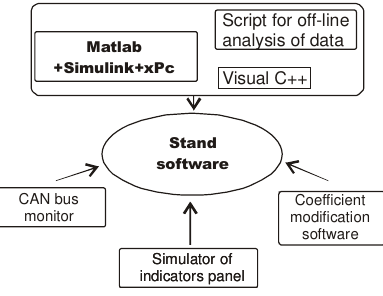
Fig 3. Diagram of laboratory stand software